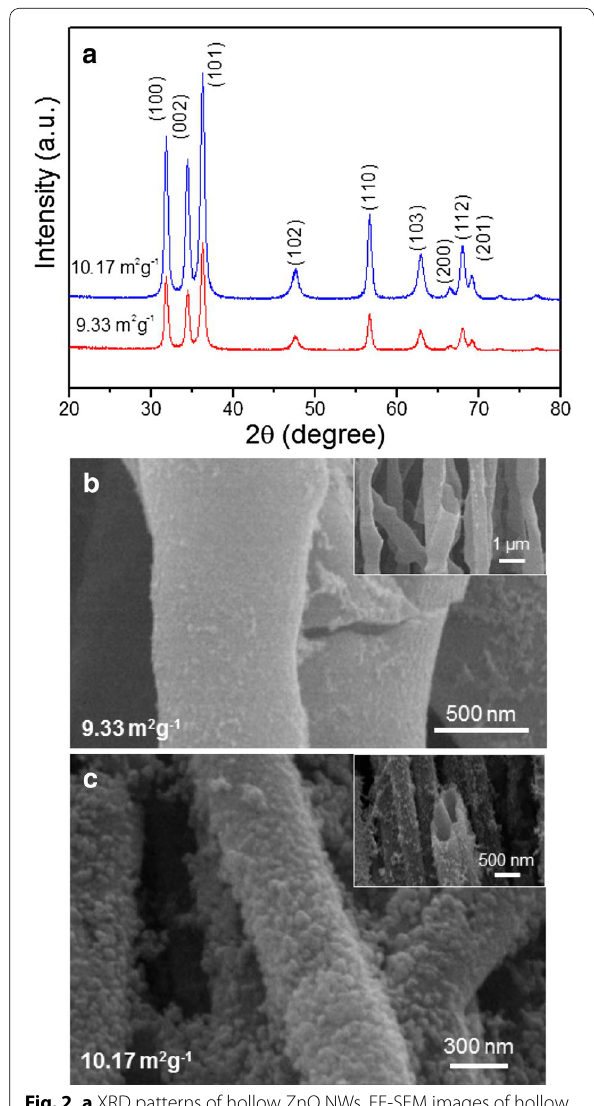
Fig. 2 a XRD patterns of hollow ZnO NWs. FE‑SEM images of hollow ZnO NWs with different surface areas: b 9.33 m 2 g − 1 . c 10.17 m 2 g −